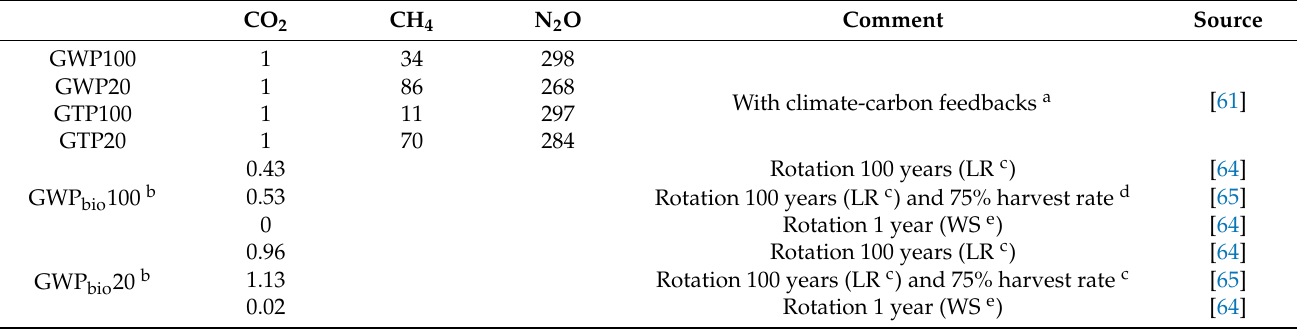
Table 2. Characterization factors for greenhouse gas emissions and climate-change impact assessment